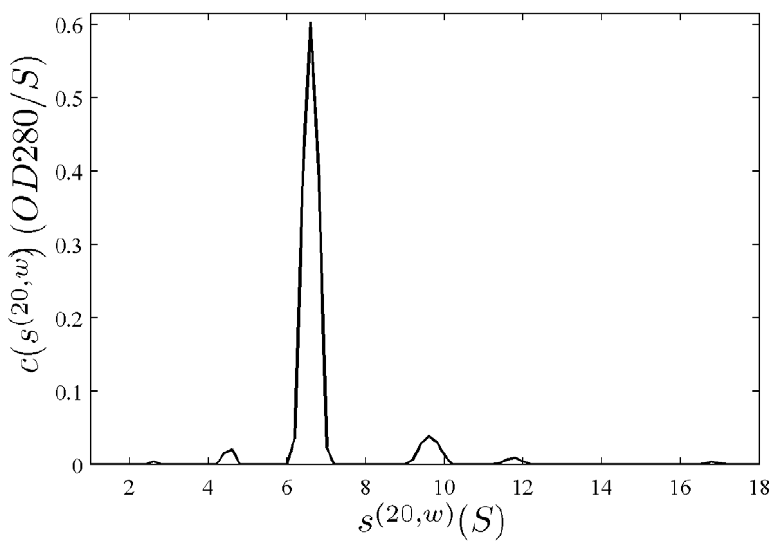
Figure 5. Sedimentation coefficient distribution for the global analysis of the absorbance data from the IgG sample (Figure 4). Relative scaling factors a 2 = a 1 and a 3 = a 1 were 0.955 and 1.034, indicating slightly different best-fit loading concentrations.